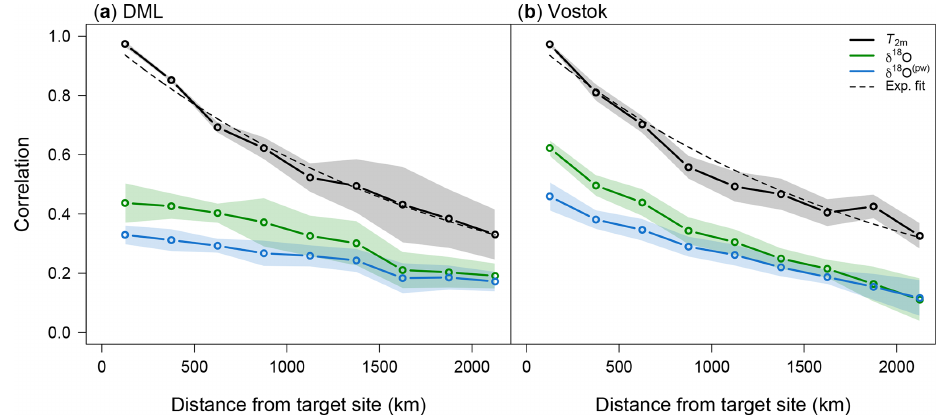
Figure 5. Average sampling correlation structures with temperature for the DML and Vostok regions in the case of sampling single locations. Shown as a function of distance is the average correlation between the interannual near-surface temperature ( T 2m ) at a target site and the spatial fields of T 2m (black), oxygen isotope composition ( δ 18 O, green), and precipitation-weighted oxygen isotope composition ( δ 18 O (pw) , blue). Averaging was performed in two steps: first, for a given target site, the correlations with the target site temperature were averaged across grid cells lying within 250km wide consecutive rings around the given target site. Secondly, this analysis was conducted for all target sites in the DML ( a ) and Vostok ( b ) region, and the results were averaged across the respective region (see Sect. 2.3.2 and 2.3.3 for details). Shading denotes ± 1 standard deviations of the correlation results across the different target sites in each region. The black dashed lines indicate an exponential fit to the T 2m